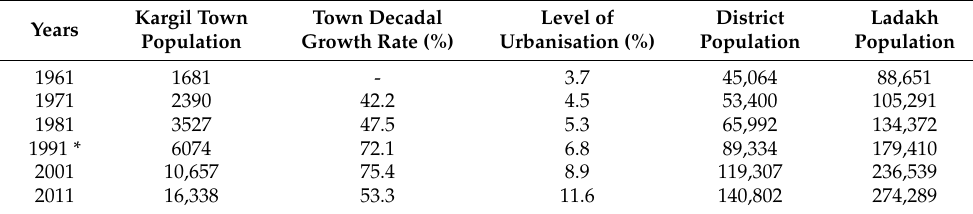
Table 5. Town population, town decadal growth rate, level of urbanisation and population of Kargil district and